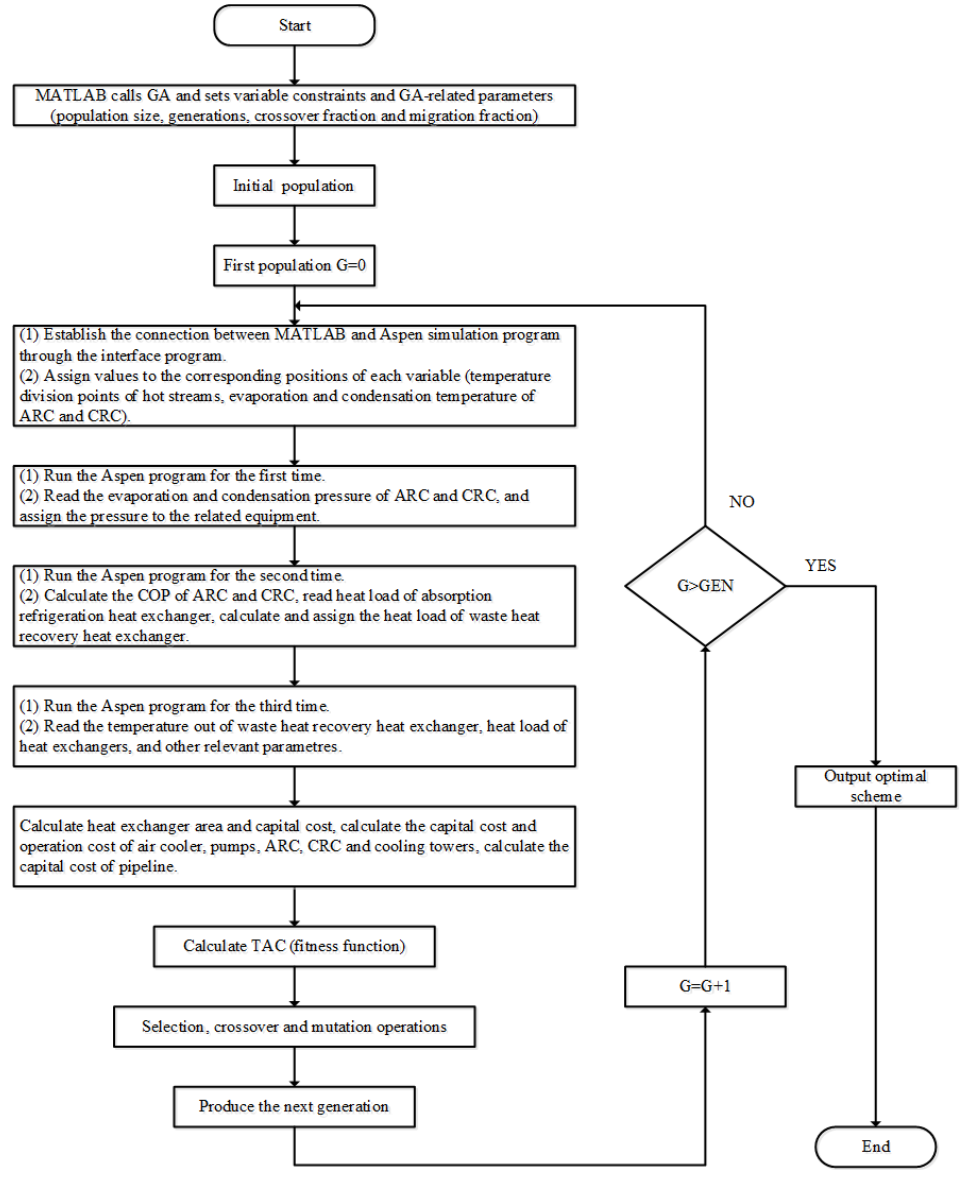
Figure 5. Block diagram of the optimization program.